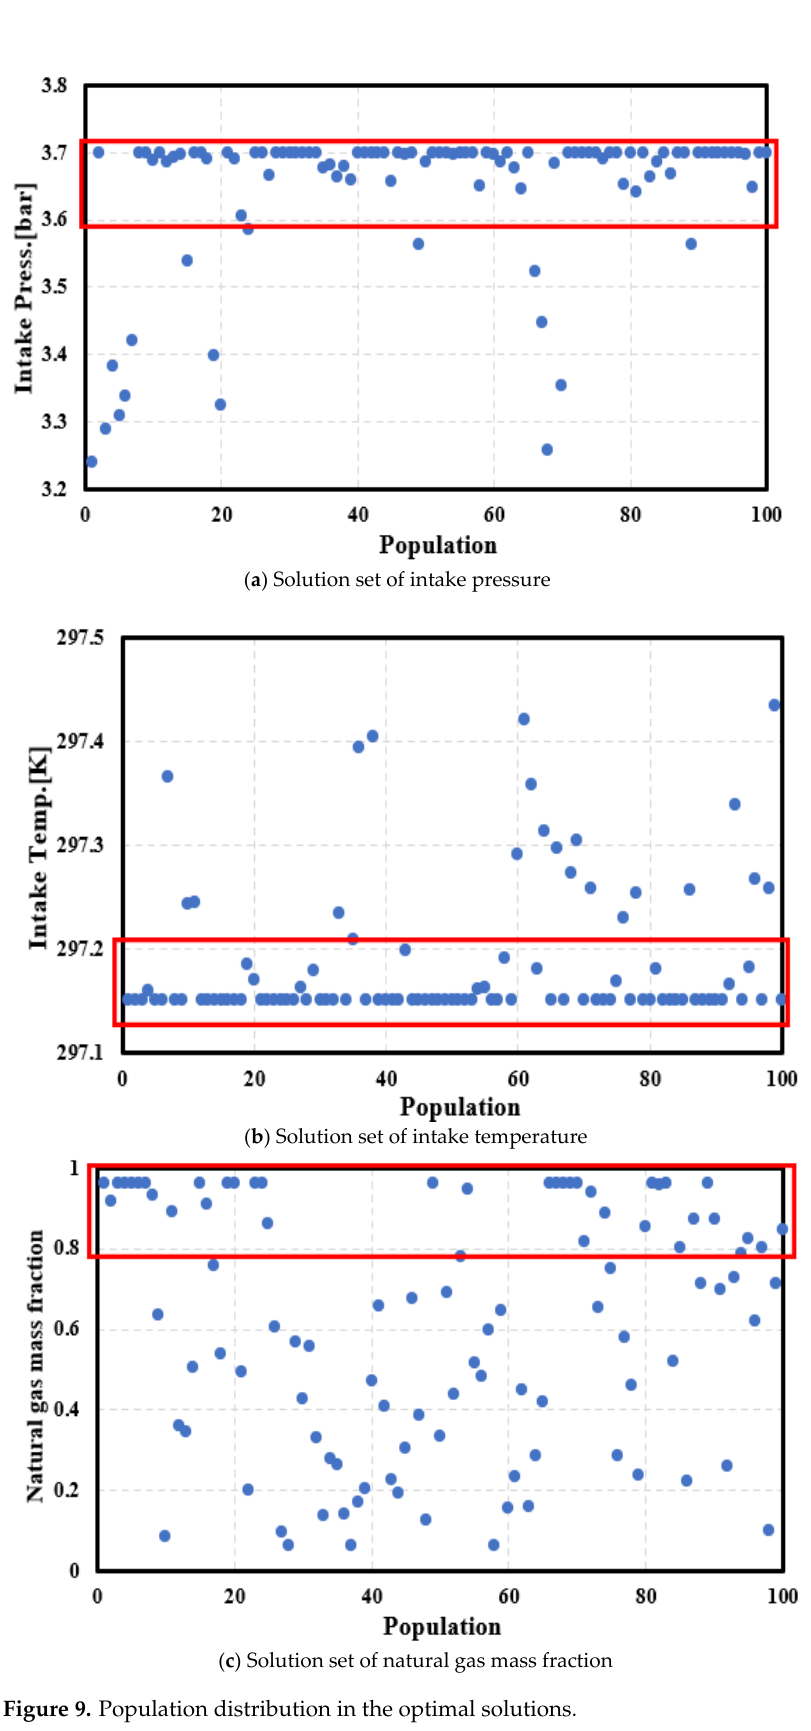
Figure 9. Population distribution in the optimal solutions.